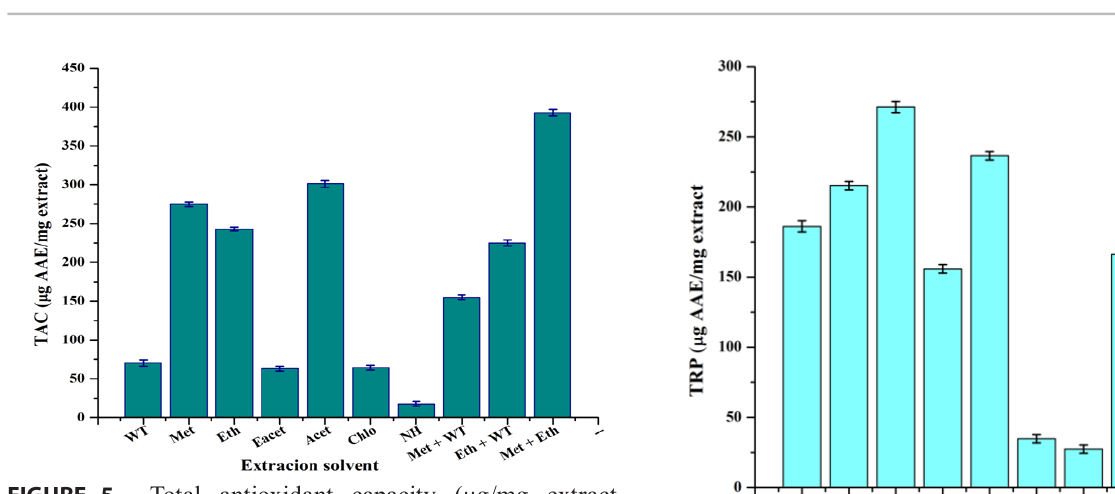
FIGURE 5 - Total antioxidant capacity (μg/mg extract ascorbic acid equivalent (AAE) of different solvent extracts of E. intermedia.